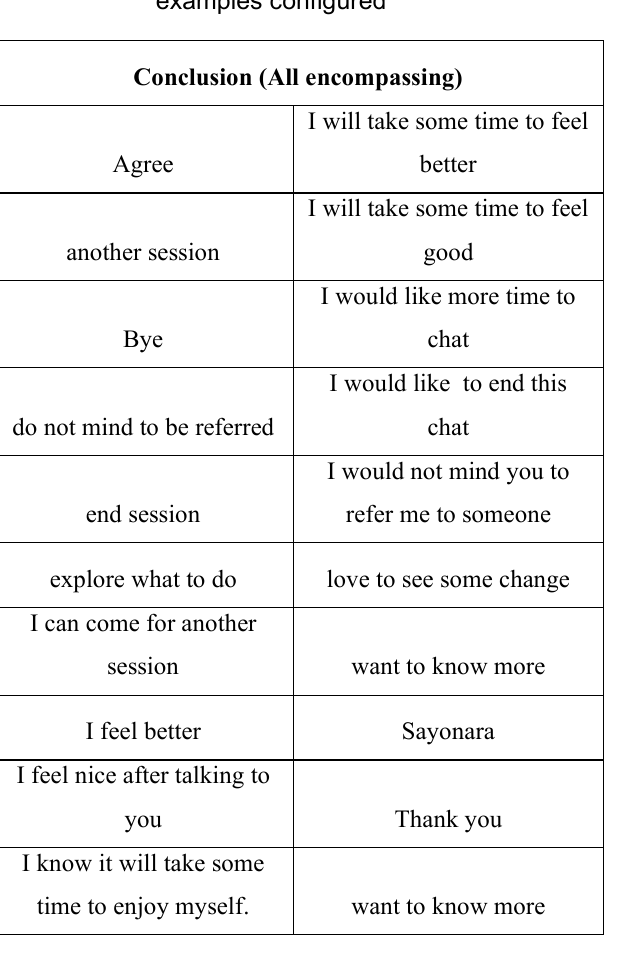
Table 14. Intent #Conclusion Details and case examples configured